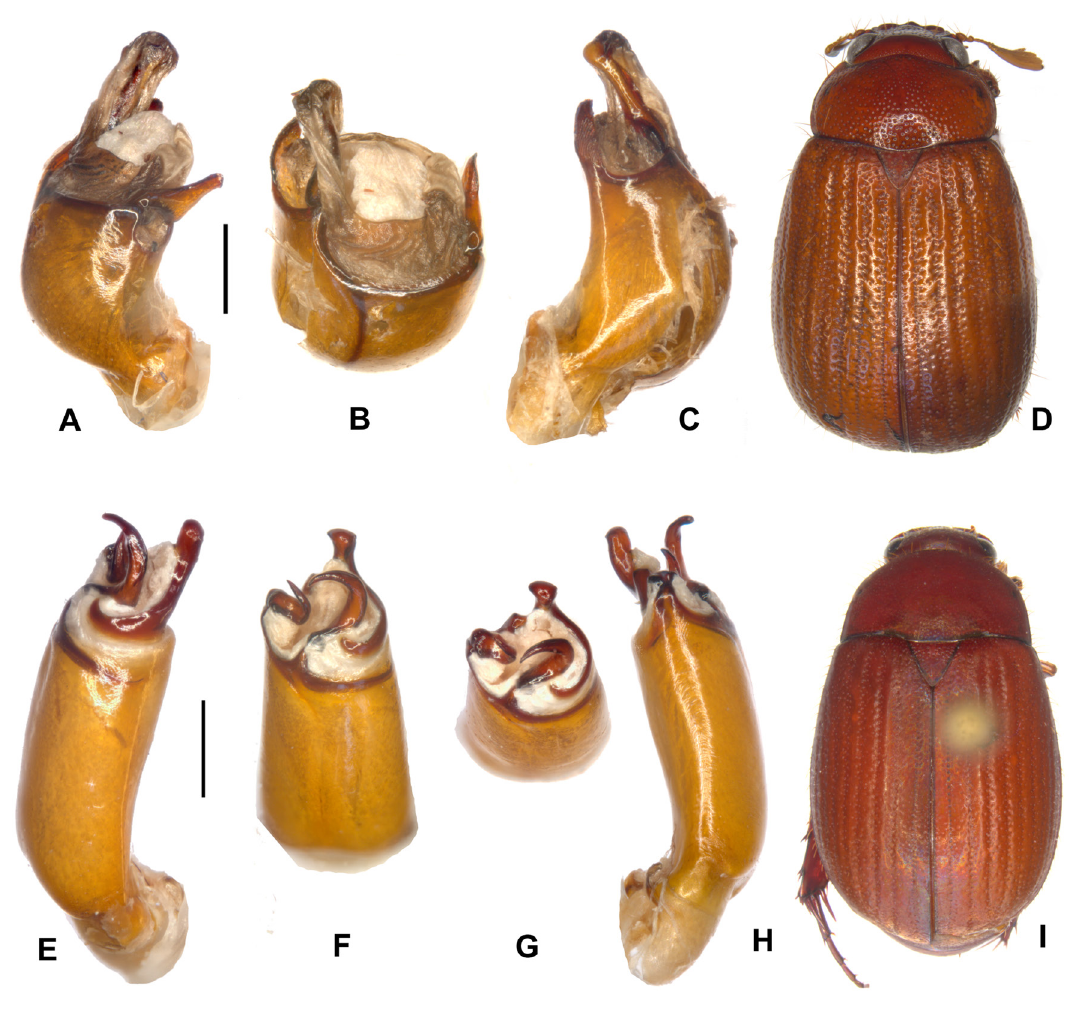
Fig. 3. A–D . Selaserica athukoralai sp. nov. (holotype) E–I . Neoserica dharmapriyai sp. nov. (holotype). A, E . Aedeagus, left side lateral view. C, H . Aedeagus, right side lateral view. B, F–G . Parameres, dorsal view. D, I . Habitus (not to scale). Scales: 0.5